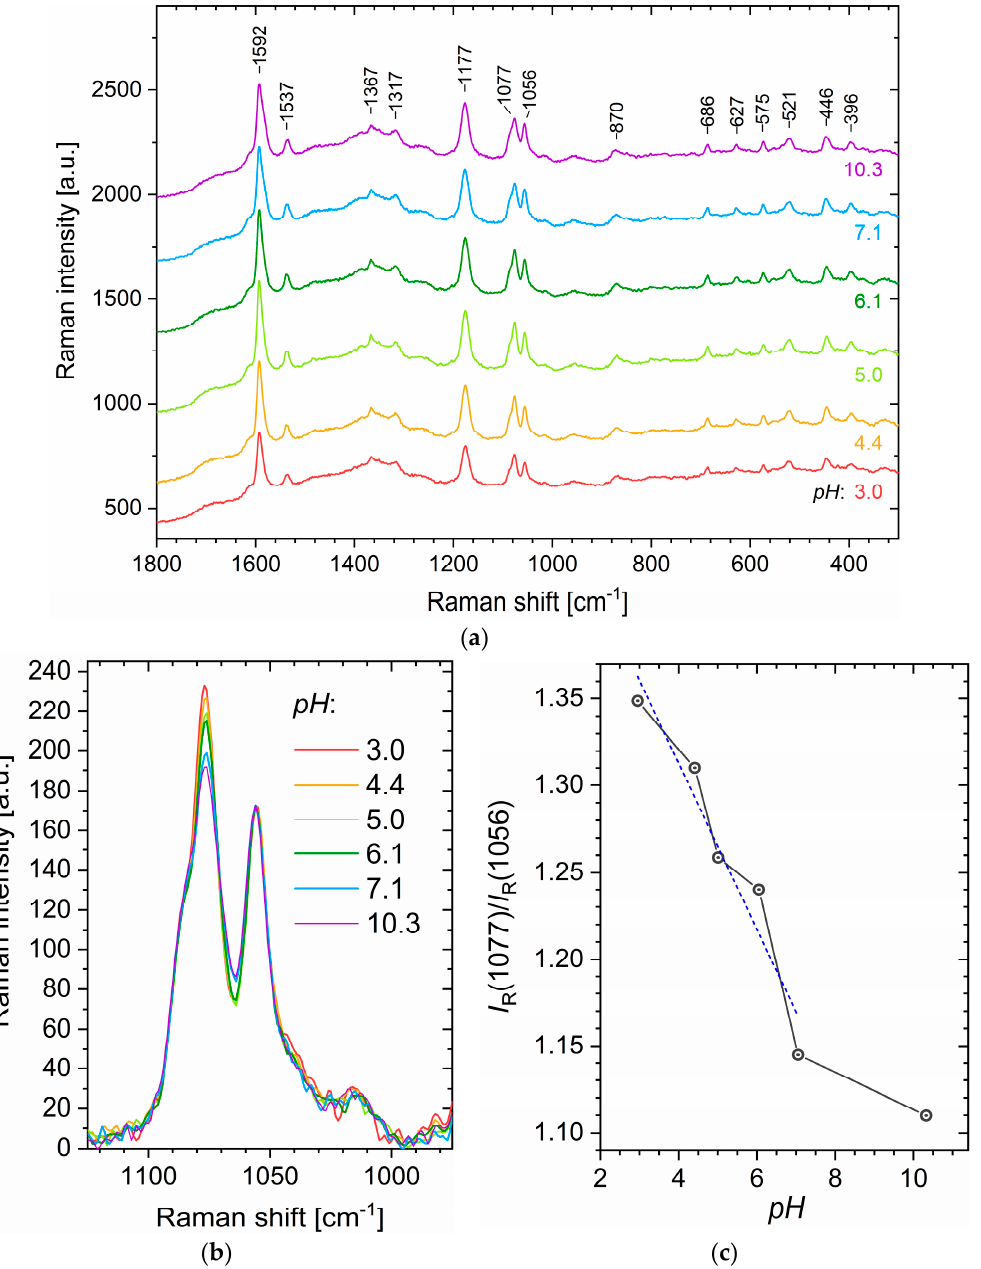
Figure 12. SERS study on aqueous suspensions of MZF@sil@Au-MBA+MMC nanoparticles whose pH was adjusted in the range of 3–10 using diluted NaOH or HCl. ( a ) Raw (unprocessed) SERS spectra measured on aqueous suspensions with varying pH and ( b ) detail of the 1125–975 cm − 1 region normalized to the MMC band at 1056 cm − 1 with the pH-dependent intensity of the MBA band at 1077cm − 1 . ( c ) The dependence of the ratio of Raman band intensities at 1077 cm − 1 and 1056 cm − 1 on pH, complemented by linear fit in the range of pH =